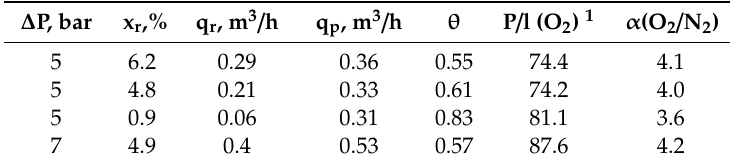
Table 3. The relation of product (nitrogen) purity with the separation characteristics of the hollow fiber membrane